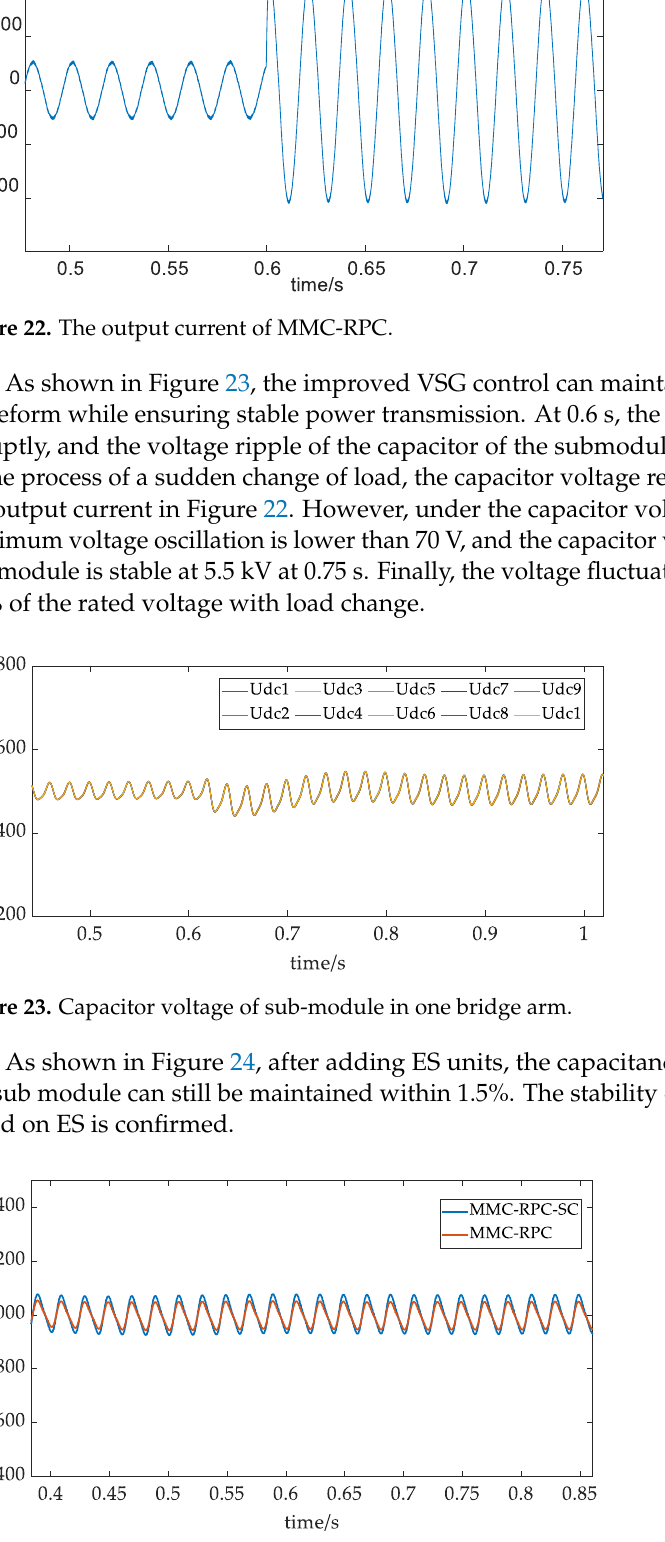
Figure 24. Capacitor voltage comparison between no energy storage and energy storage.